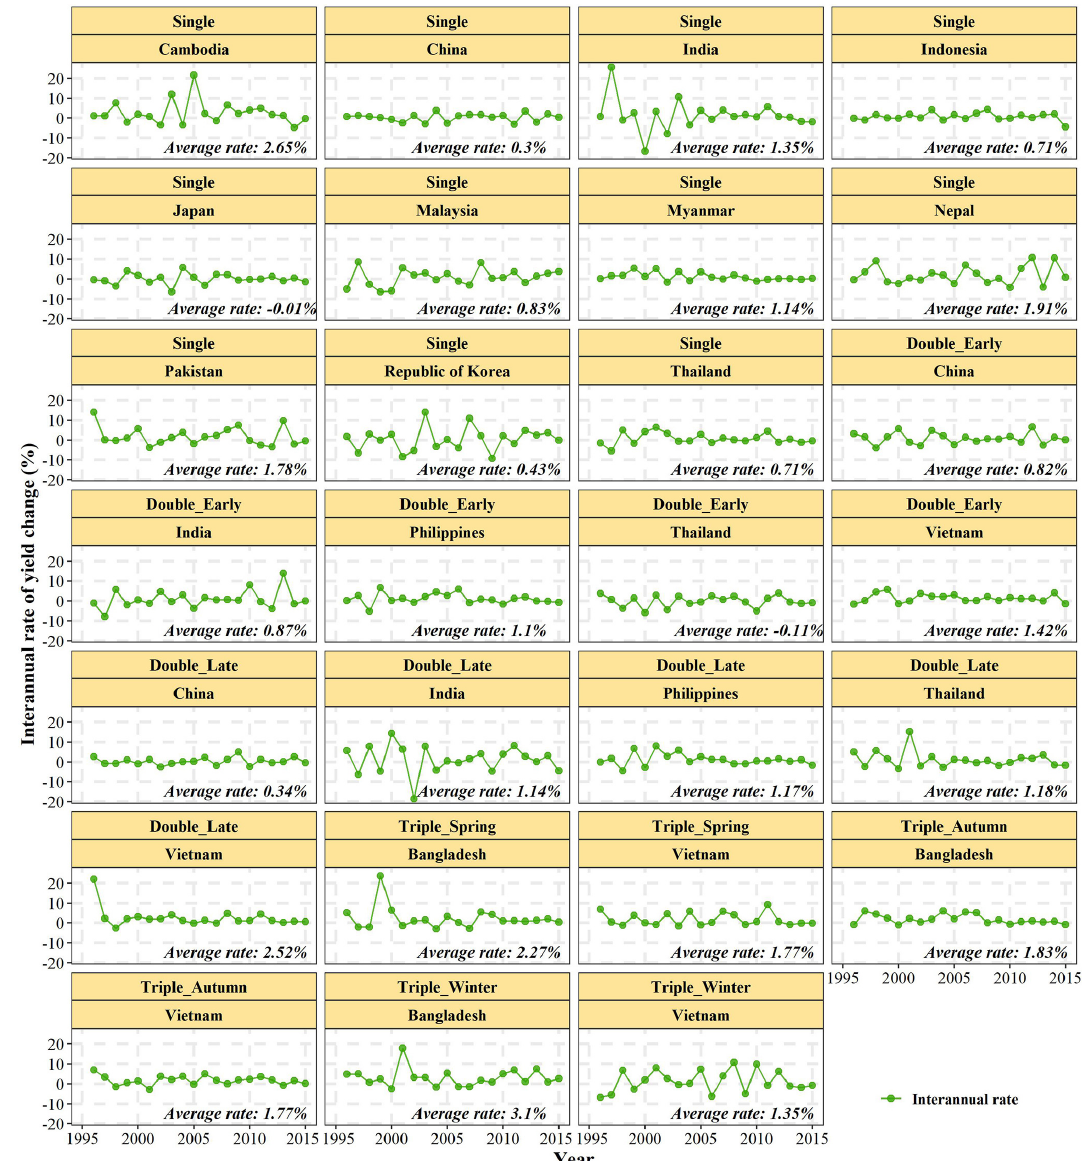
Figure 8. Temporal variation in the estimated rice yield change for different seasons from 1995 to